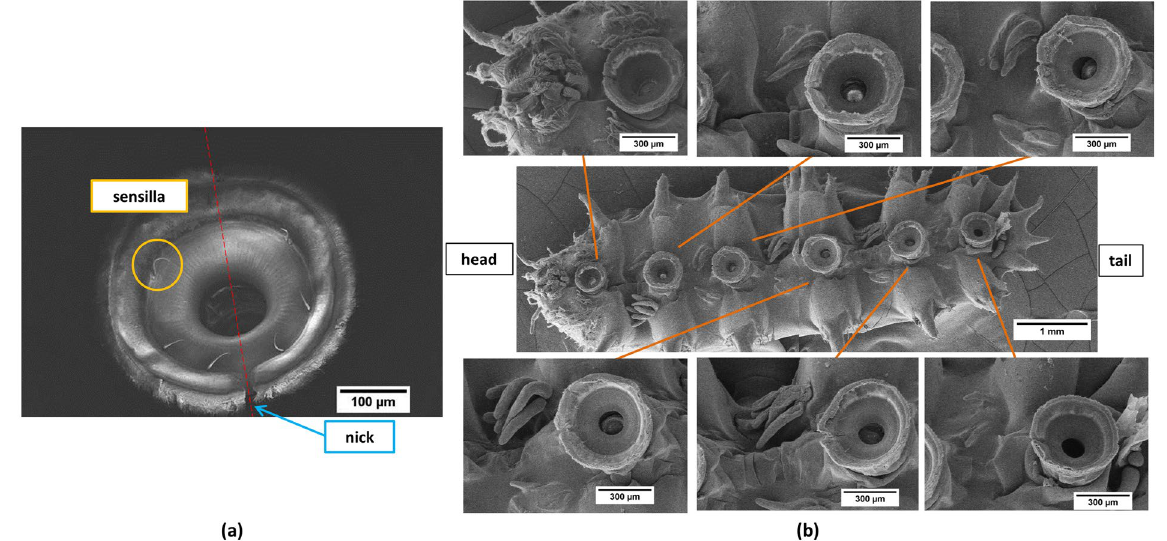
Figure 3. ( a ) Six sensilla are on the rim of the wrinkled surface part of the larva of Blepharicera ’s sucker. The sensilla locate symmetrically along the central line through the nick. ( b ) SEM images of the larva of Blepharicera sp. show that the nicks are aligned in a direction toward the